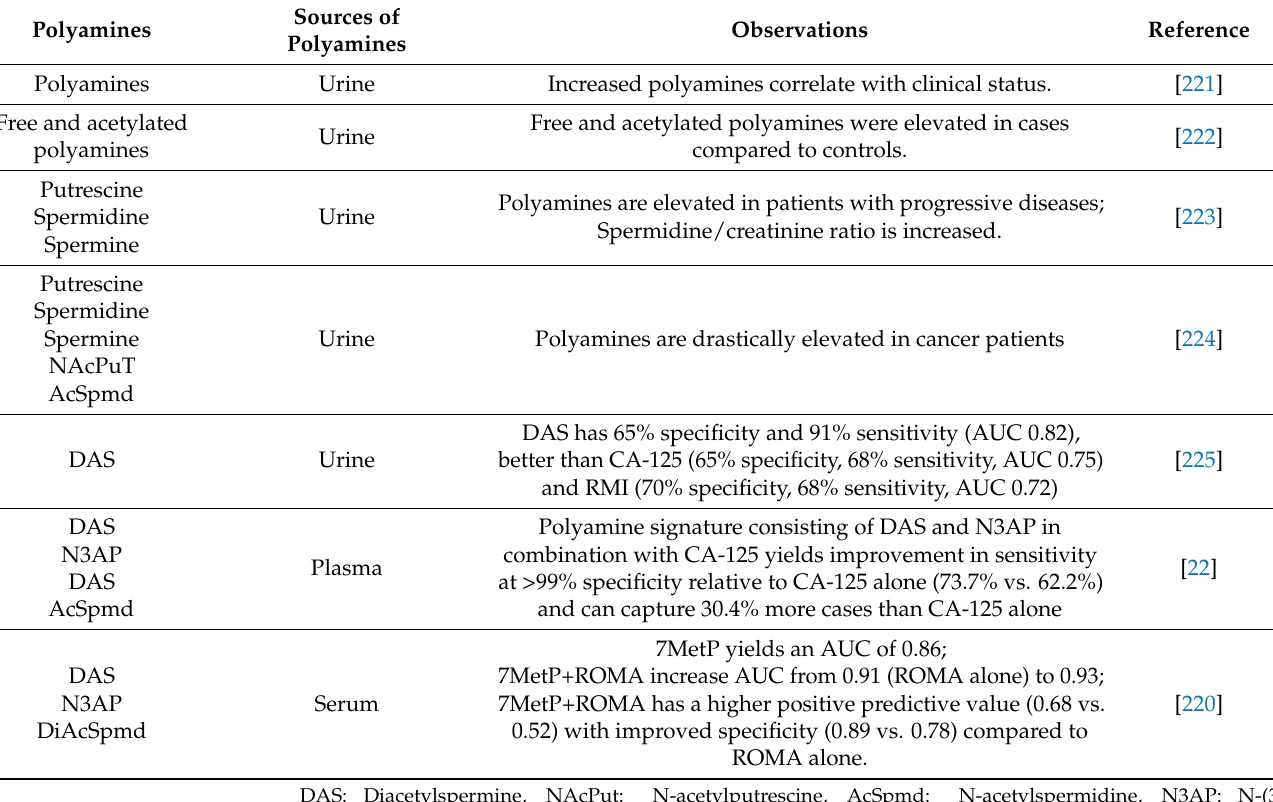
Table 1. Polyamine as biomarkers for ovarian